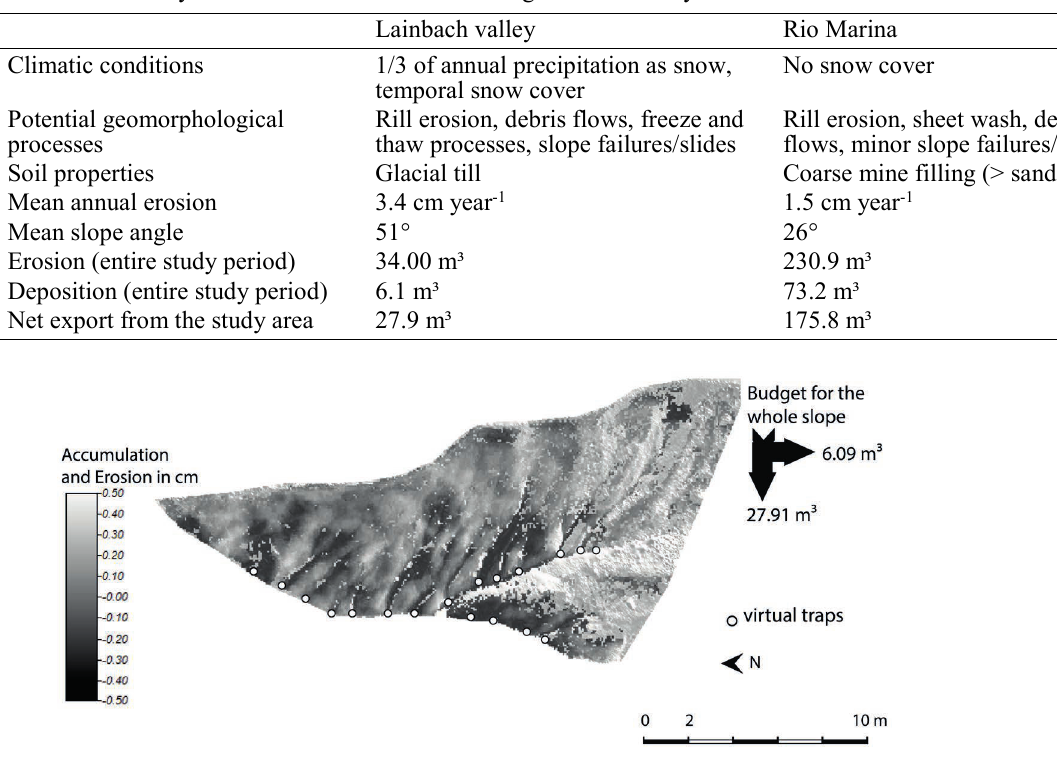
Fig. 2 Erosion and accumulation estimates for the hill slope in the Lainbach valley from July 2009 to Oct. 2013. The arrows indicate the amount of material deposited on the slope and transported out of the study area. “Virtual traps” at the bottom of the gullies are represented by circles.